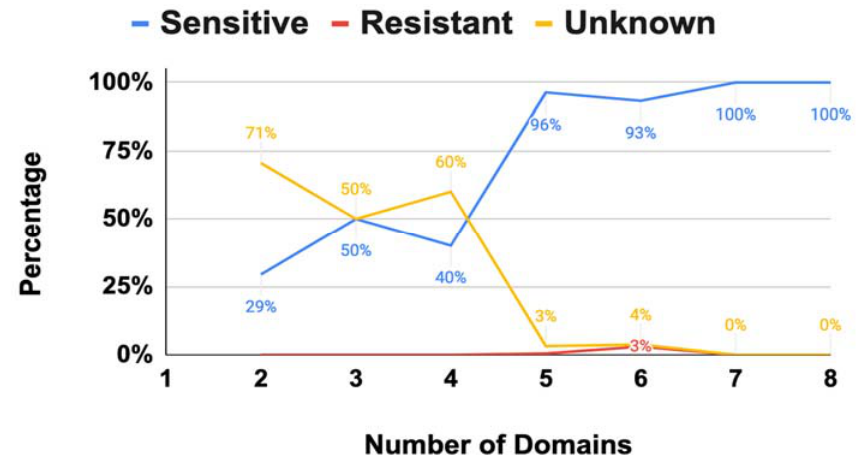
Figure 4. Distribution of sensitive, resistant, and unknown EPSPS sequences to glyphosate.